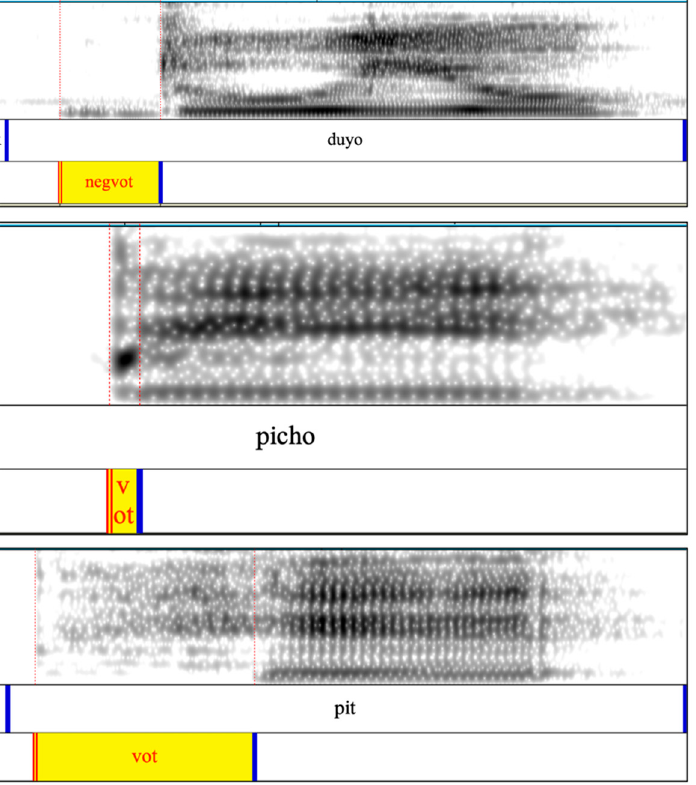
Figure 2. Segmentation of a stop consonant with ( Top ) prevoicing or negative VOT, ( Middle ) without aspiration, and ( Bottom ) with